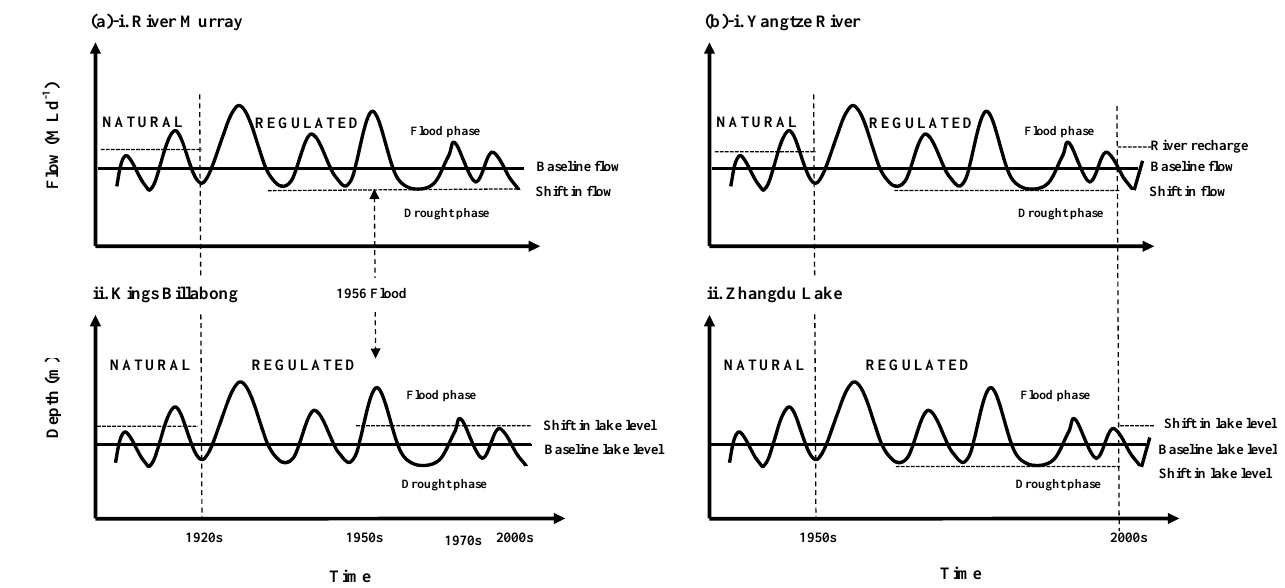
Figure 2. Hydrological contexts of the Murray and Yangtze rivers. River Murray: regulation was imposed by humans in the 1920s which resulted in low water volume in the downstream river channels, but Kings Billabong’s conversion to a water storage tank permanently led to higher lake level, subsequently ceased natural dry–wet cycles; (a-i) and (a-ii) (left panel). Yangtze River: the first large-scale human impact on the river was imposed during the ca. 1950s, which ceased naturally occurring flood pulses in adjacent wetlands leading to a drying up of the river channel connecting to wetlands including low water volume in Zhangdu Lake; (b-i) and (b-ii) (right